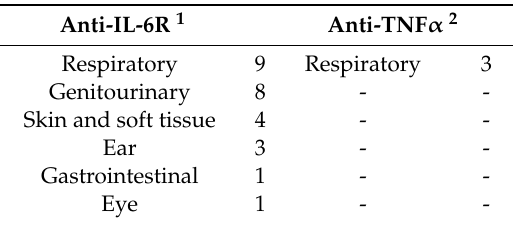
Table 3. Type of infection in